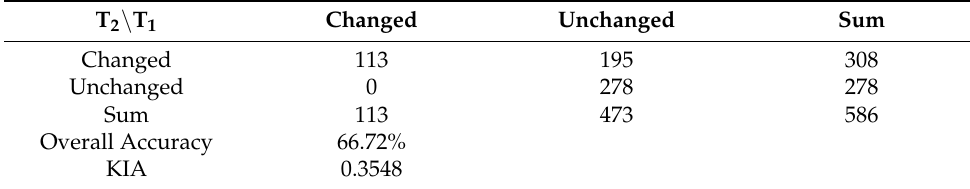
Table 10. Super pixel cosegmentation change detection confusion matrix.